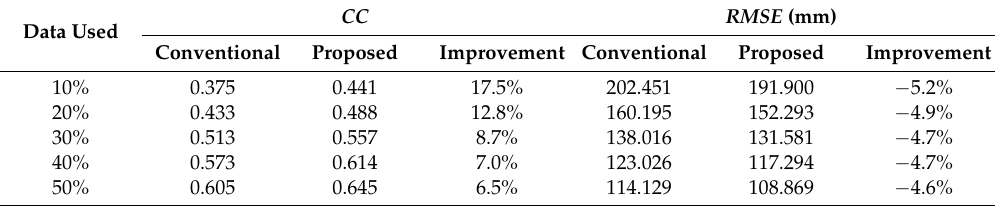
Table 4. Comparison between the proposed and the conventional strategies under different levels of rainfall. CC RMSE Data Used